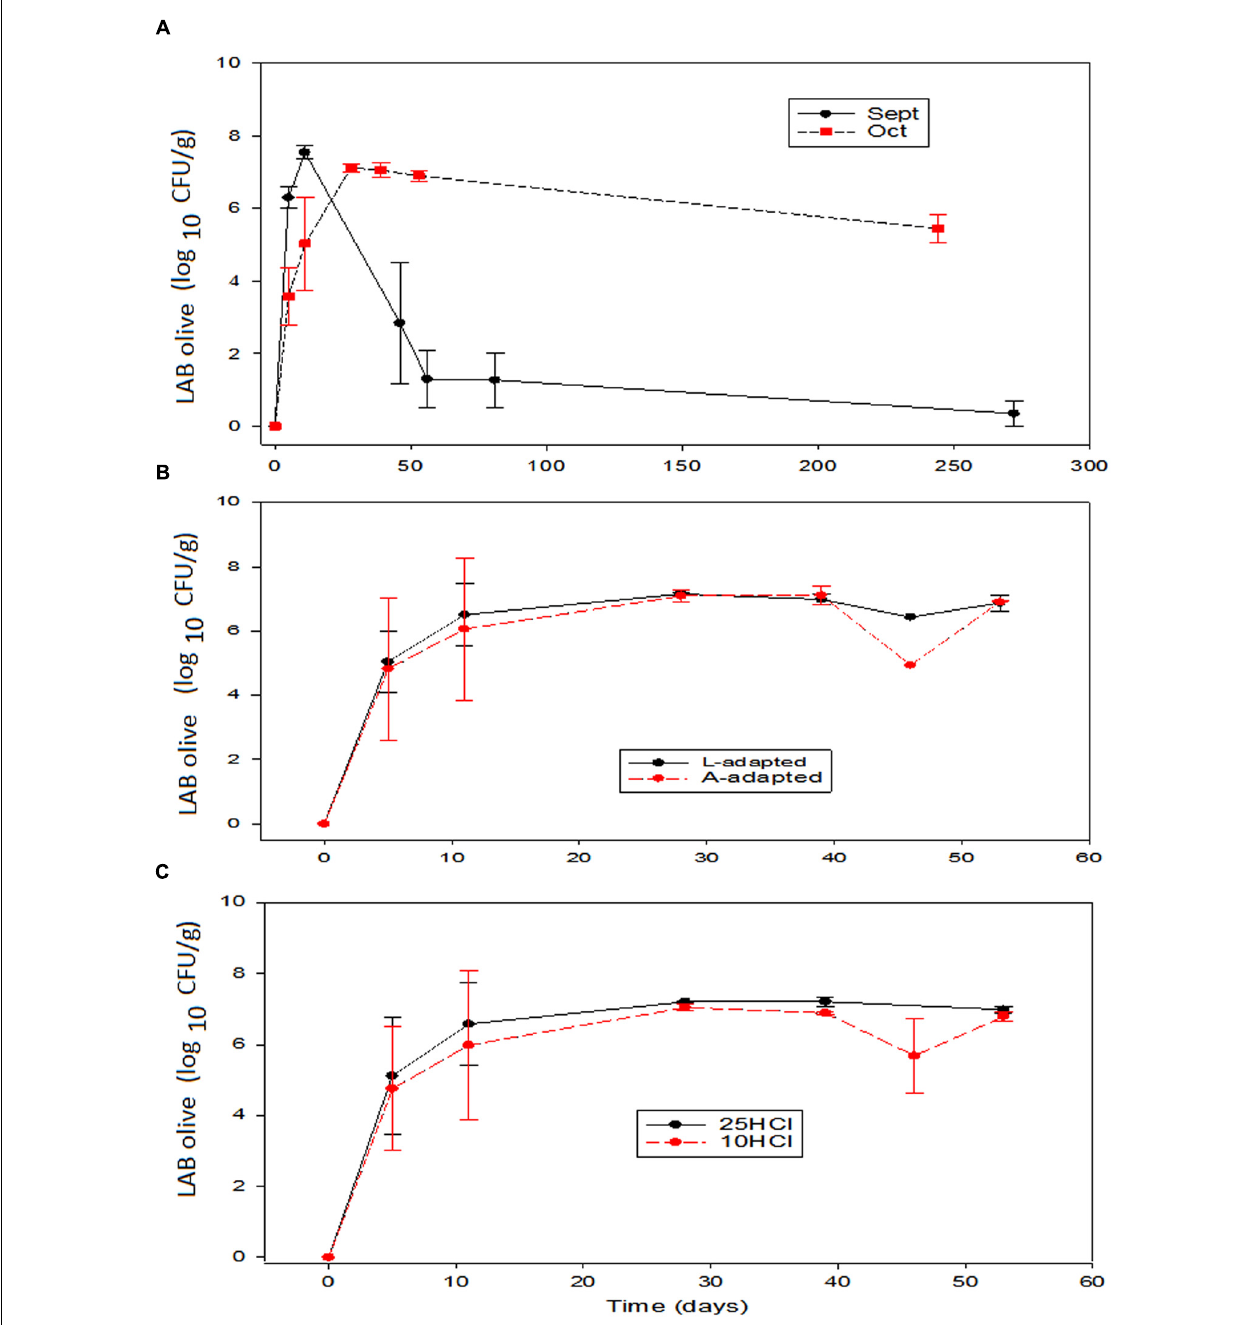
FIGURE 5 | Application of potential probiotic starter (LAB2) at industrial scale (season 2012/2013). Changes in LAB on olives ( ± CL, n = 4 for each level) according to time season (A) , type of inoculum (B) , and proportion of HCl added to fermentation vessels (C) . The values are always averages over the other two non-included in the graph variables. See Figure 1 for the meanings of